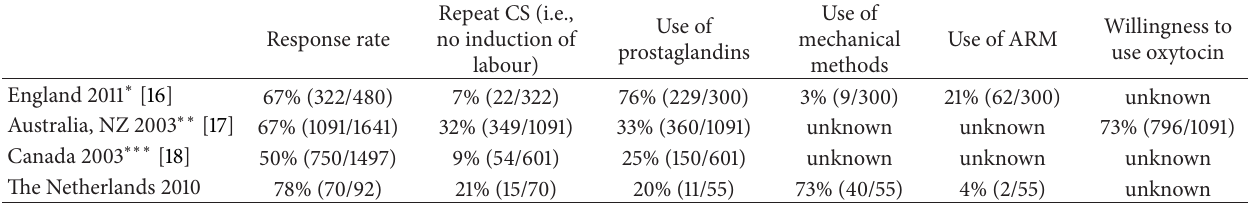
Table 6: Comparison of international surveys of current practice of induction of labour in women with a prior cesarean birth.